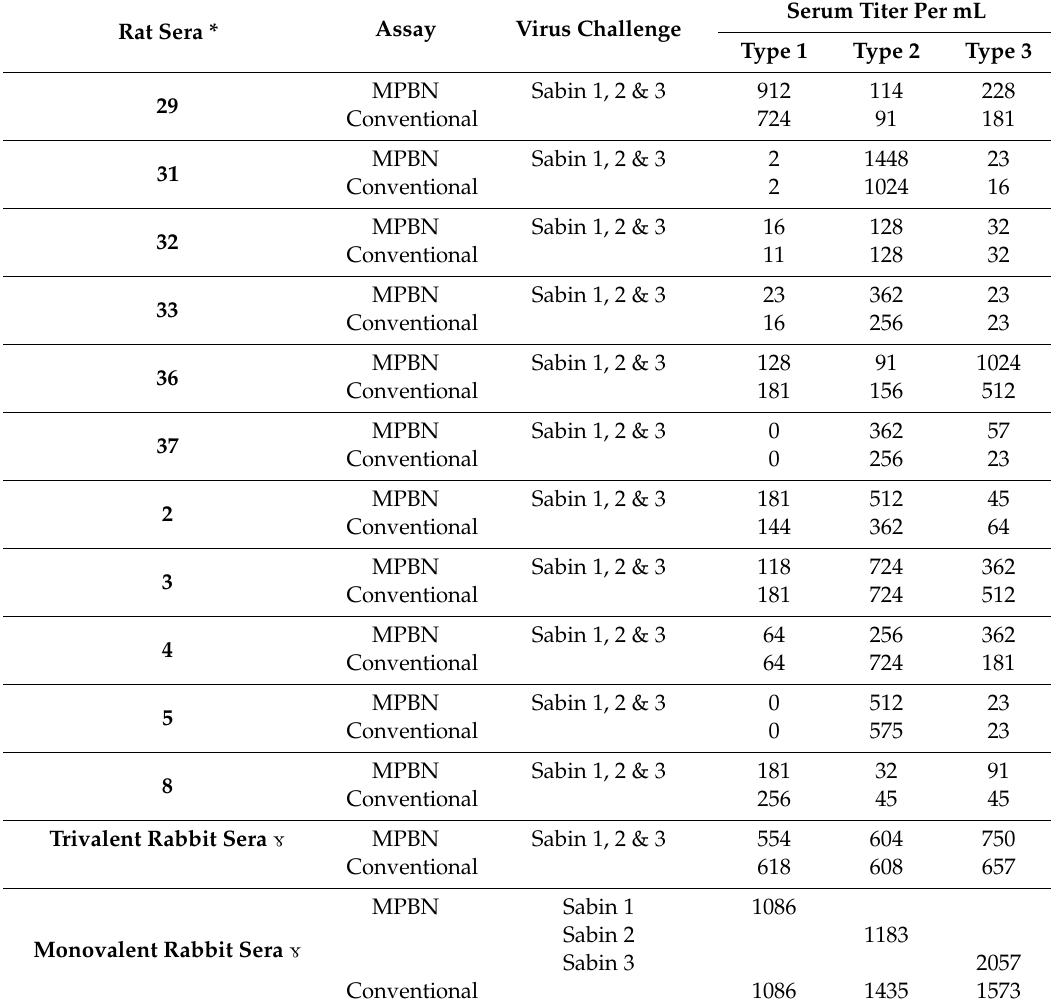
Table 3. Titration of rat and rabbit anti-poliovirus sera type 1, 2 and 3 with MPBN and conventional neutralization assays.